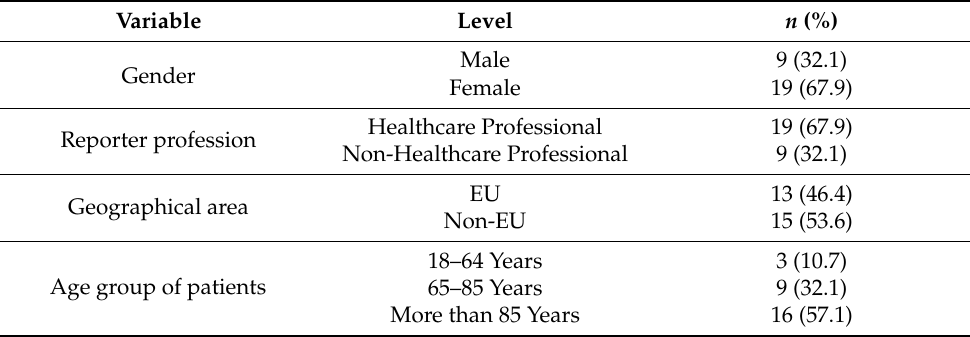
Table 1. Summary of demographics of the EudraVigilance (EV) database reported Astra-Zeneca vaccine adverse drug reaction (ADR) events ( N = 28).